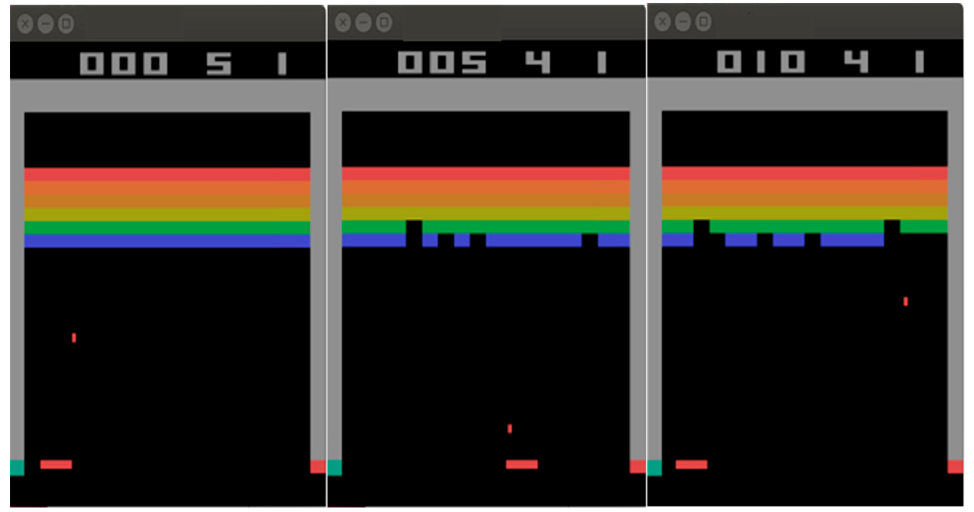
Figure 16. The Atari Breakout game.